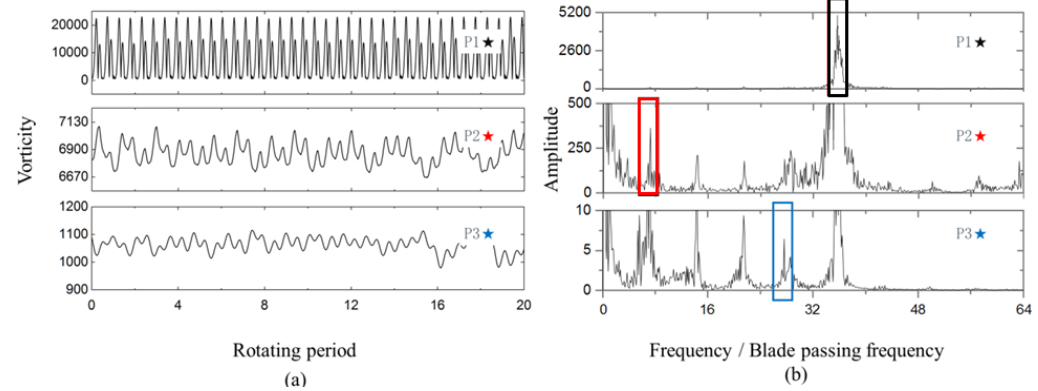
Figure 7. Vorticity fluctuations in time domain ( a ) and frequency domain ( b ) at monitor points.